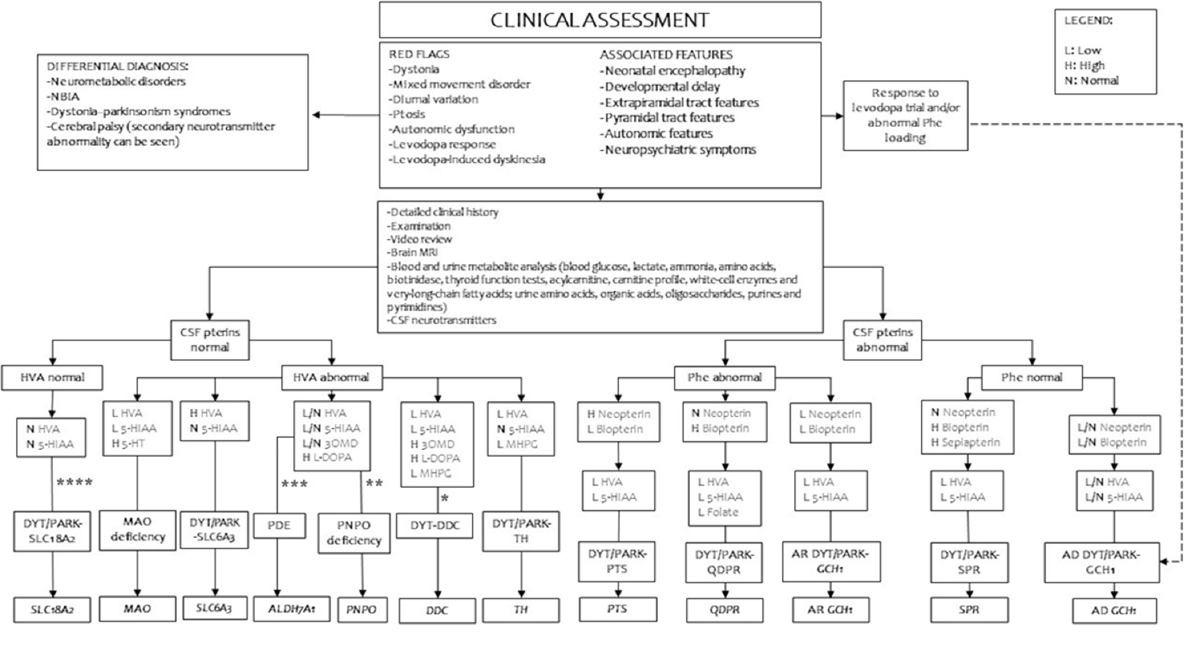
Figure 2. Suggested diagnostic work ‐ up in patients with suspected defects of inherited monoamine neurotransmitter disorders. LEGEND: 3OMD, 3 ‐ O ‐ methyldopa; 5 ‐ HIAA, 5 ‐ hydroxyindoleacetic acid; AADC, aromatic l ‐ amino acid decarboxylase; AD, autosomal dominant; ALDH7A1 , aldehyde dehydrogenase 7 family member A1; AR, autosomal recessive; CSF, cerebrospinal fluid; DDC , DOPA decarboxylase gene; GCH1 , GTP cyclohydrolase 1 gene; PTS , 6 ‐ pyruvoyltetrahydropterin synthase gene; QDPR , quinoid dihydropteridine reductase gene; SLC6A3 , solute carrier family 6 member A3, dopamine transporter gene; SLC18A2 , solute carrier family 18 member A2, vesicular monoamine transporter 2 gene; SPR , sepiapterin reductase gene; TH , tyrosine hydroxylase gene; HVA, homovanillic acid; MAO , monoamine oxidase gene; MHPG, 3 ‐ methoxy ‐ 4 ‐ hydroxyphwnyl ‐ glycol; NBIA, neurodegeneration with brain iron accumulation; PNPO , pyridoxamine 5’ ‐ phosphate oxidase gene.